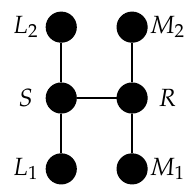
Figure 1. The graph H